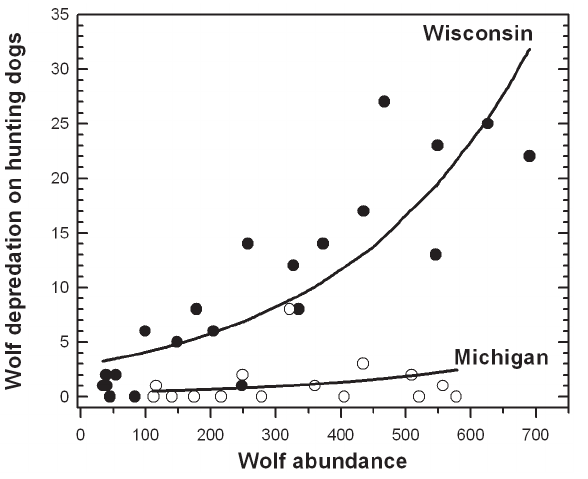
Figure 1. Distinct wolf conflict patterns in the upper Great Lakes region, USA. Poisson log-linear relationship between annual totals of wolf depredation (i.e. kill or injury) on bear-hunting dogs ( y- axis ) and annual estimates of wolf abundance ( x-axis ) in Wisconsin (1990–2010; closed symbols ) and Michigan (1996–2010; open symbols ).